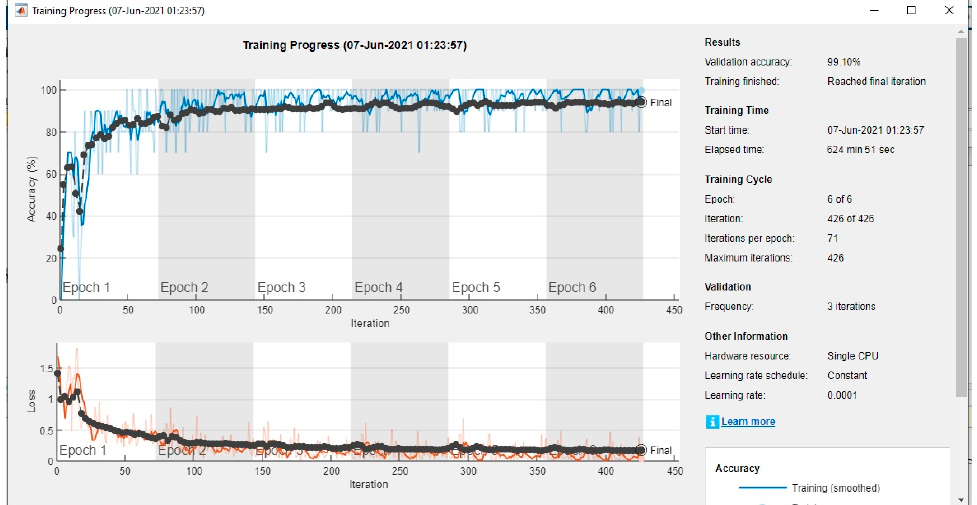
Figure 15. ResNet101 training progress.